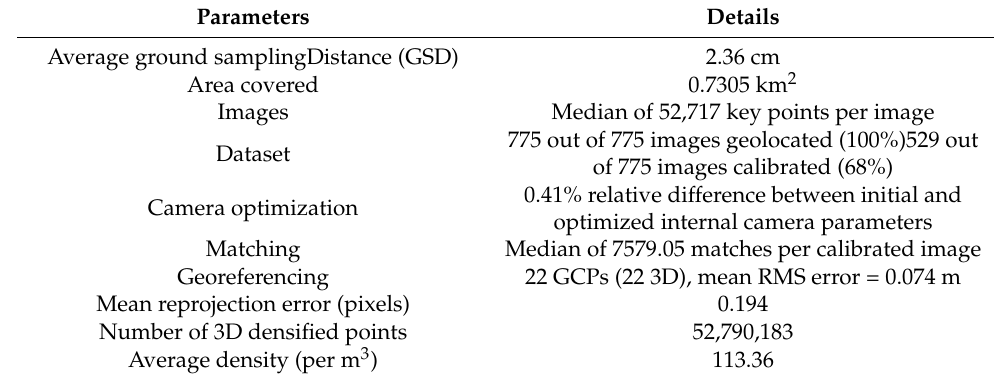
Table 1. Details of UAV photogrammetric data processing for the generation of georeferenced 3D point cloud